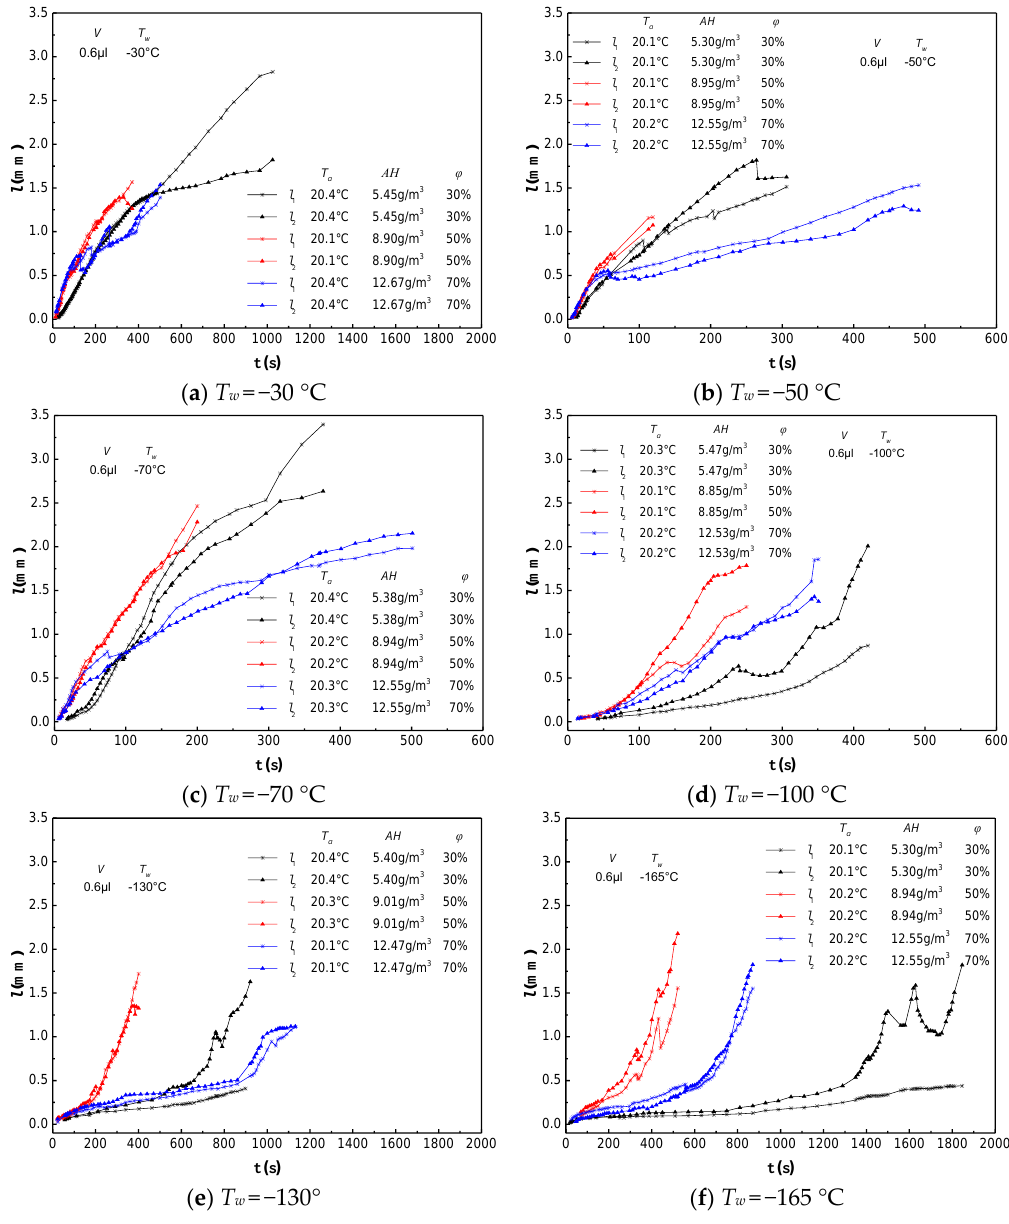
Figure 8. Influences of air relative humidity temperature on frost crystal dendrite growth along vertical direction.